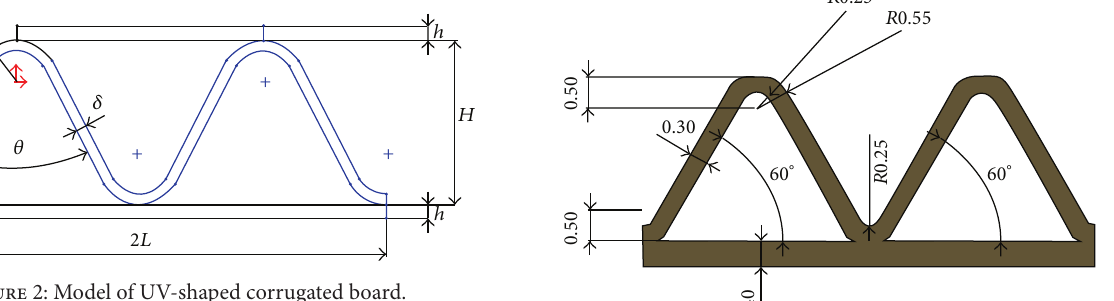
Figure 2: Model of UV-shaped corrugated board.